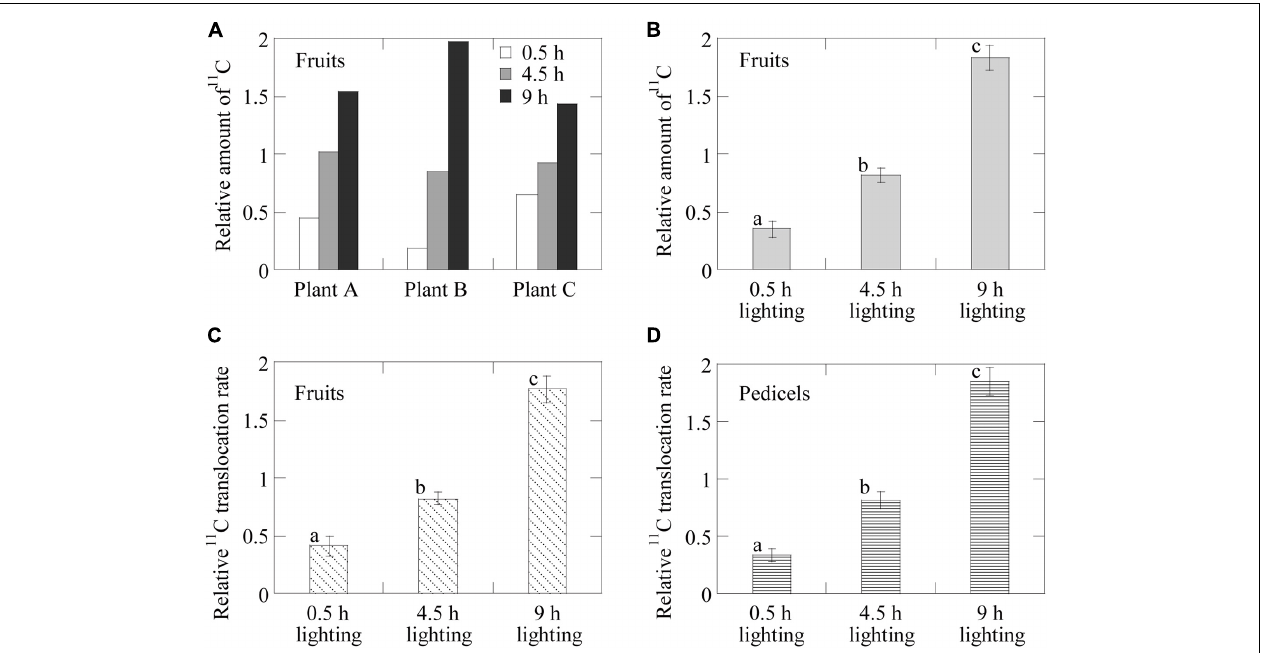
FIGURE 6 | Average relative 11 C-photosynthate translocation rates and the amounts of 11 C-photosynthates translocated into the fruits having confirmed 11 C-photosynthate translocation. Average relative amount of 11 C-photosynthates translocated into the fruits (A) of each individual plant in response to the 0.5-, 4.5-, and 9-h lighting treatments and (B) in all the plants for each lighting treatment. Average relative 11 C-photosynthate translocation rate (C) for the fruits in all the plants for each lighting treatment and (D) in the phloem of the pedicels of all the plants in response to the 0.5-, 4.5-, and 9-h lighting treatments. Different letters indicate significant differences ( p < 0.05) as determined by the Tukey–Kramer